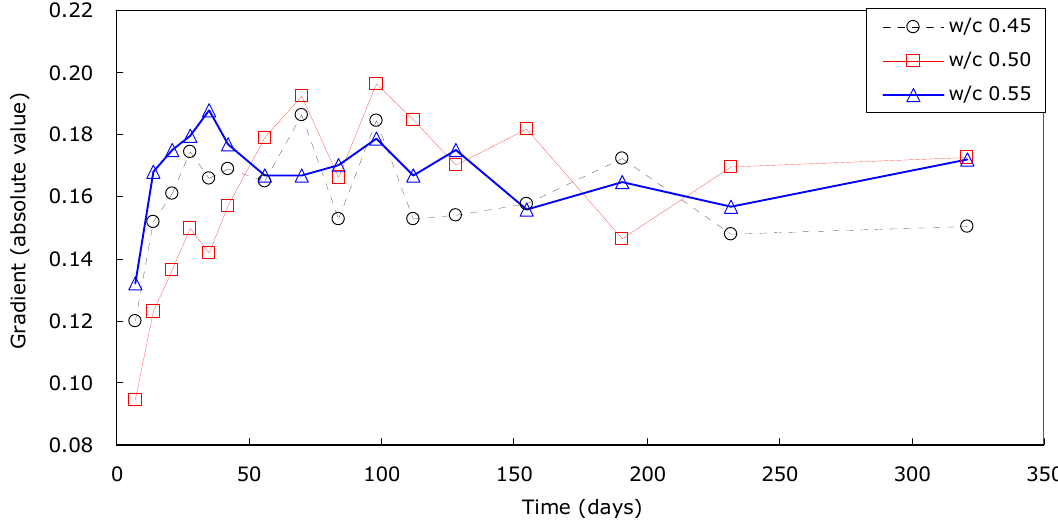
Figure 10. Gradient in the linear regression deriving from the resistivity ratio vs. chloride concentration.